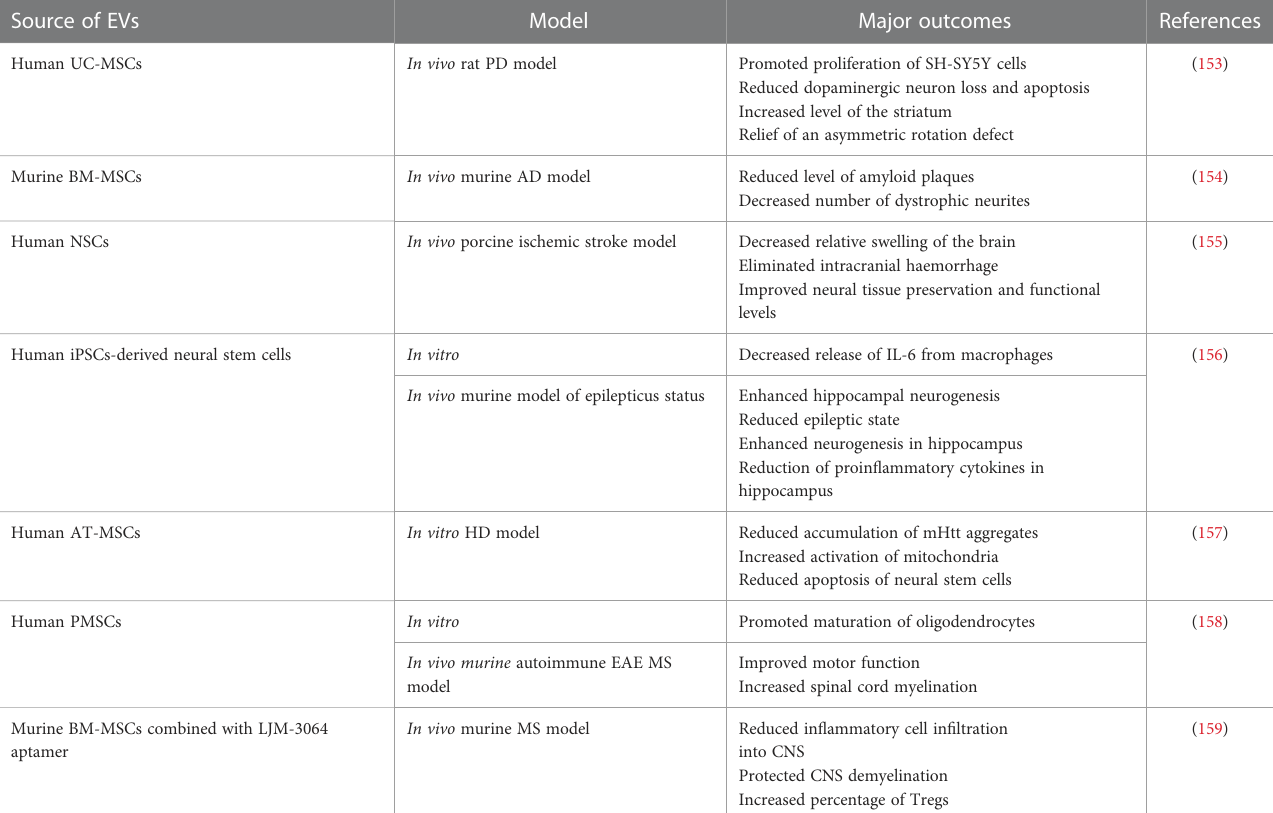
TABLE 2 Examples of EV use in preclinical studies related to the therapy of neurological and neurodegenerative disorders. Source of EVs